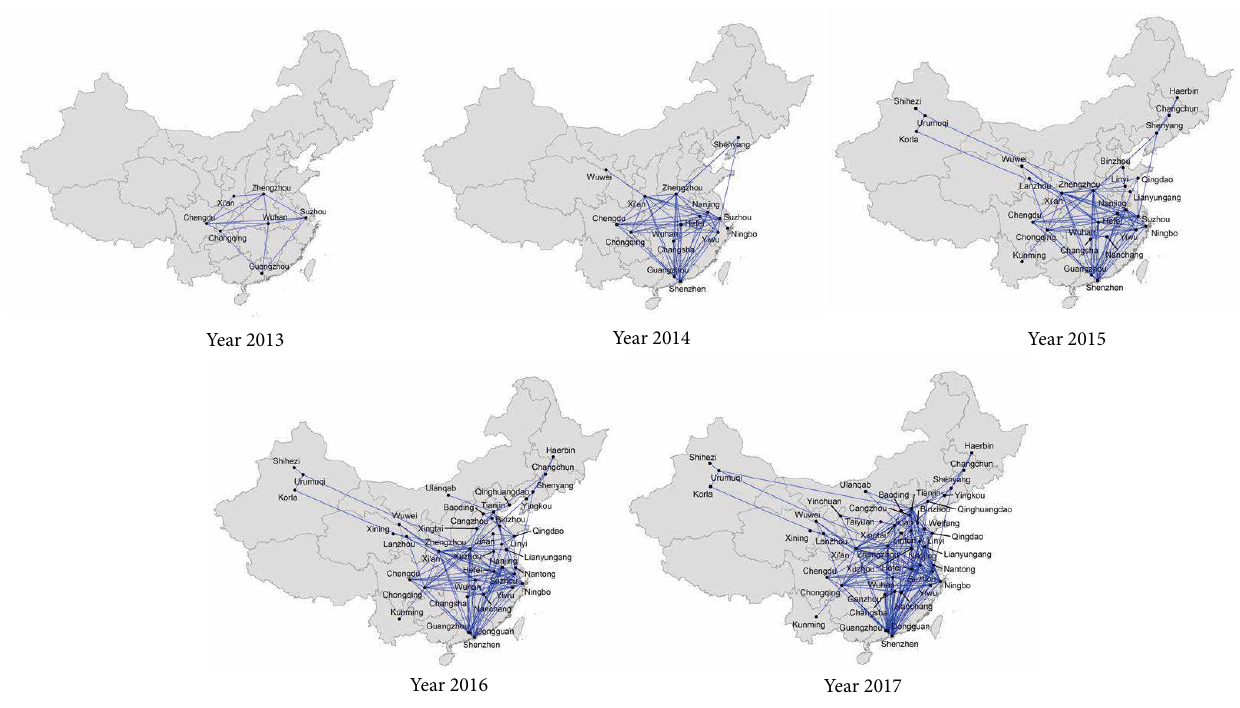
Figure 5: Evolution of the CRECN network topology.